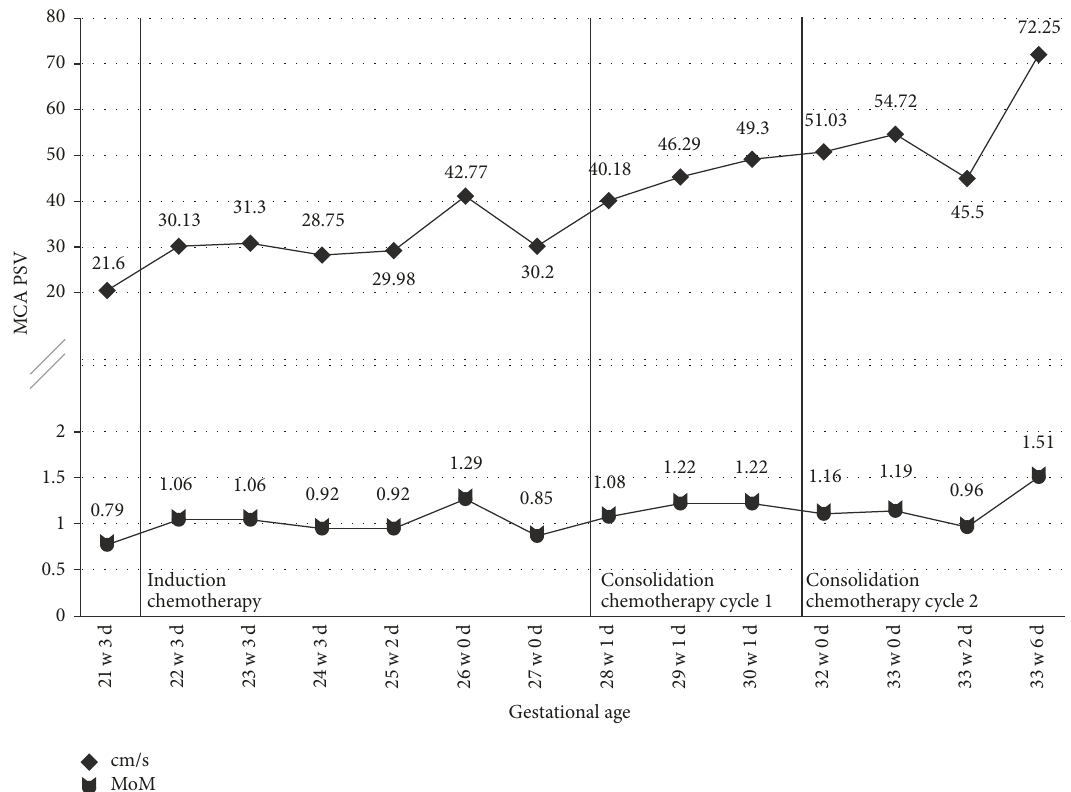
Figure 1: MCA PSV measurements for Case 1. Vertical lines indicate the time of chemotherapy administration. PSVcm/s, peak systolic velocity measurement; MoM, multiples of mean of PSV measurement for corresponding gestational age.